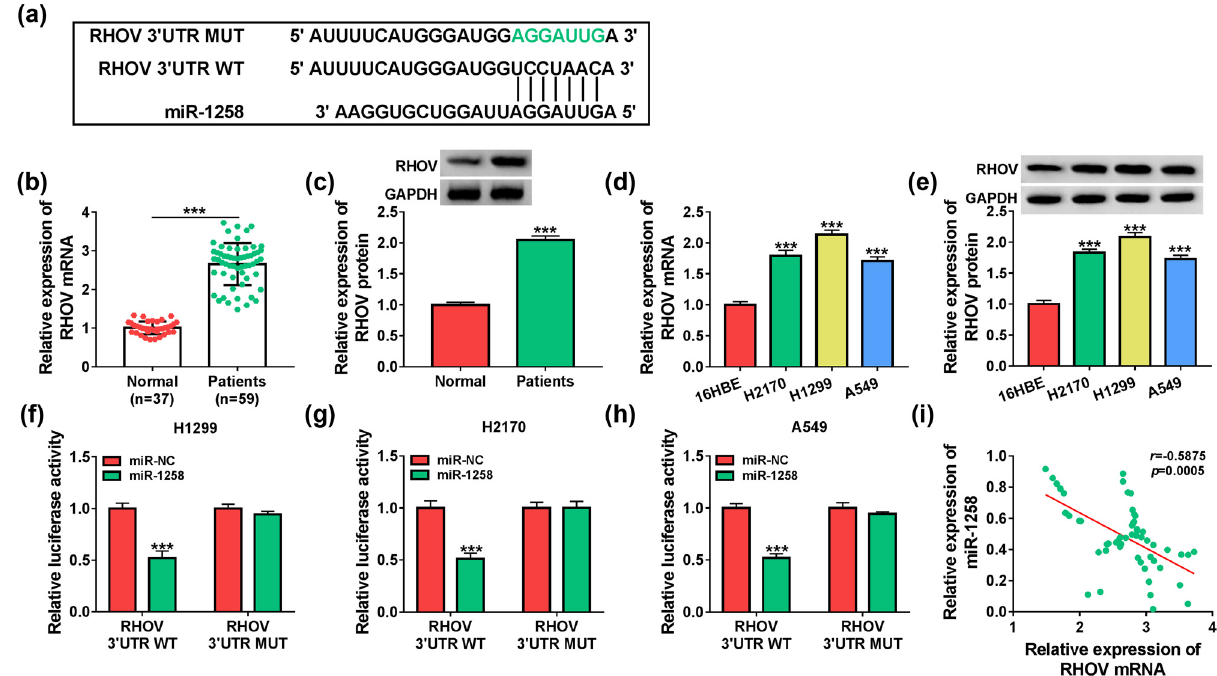
Figure 6: RHOV is targeted via miR - 1258. ( a ) The binding sites of miR - 1258 and RHOV were predicted by TargetScan. ( b and c ) RHOV abundance was detected using qRT - PCR and Western blotting in the serum samples of NSCLC patients or normal subjects. ( d and e ) RHOV abundance was measured via qRT - PCR and Western blotting in H2170, H1299, A549, and BEAS - 2B cells. ( f – h ) Luciferase activity was detected in the H1299, H2170, and A549 cells transfected with RHOV 3 ′ UTR WT or RHOV 3 ′ UTR MUT and miR - NC or miR - 1258 mimic. ( i ) The linear correlation of miR - 1258 and RHOV levels in NSCLC patients. *** P <